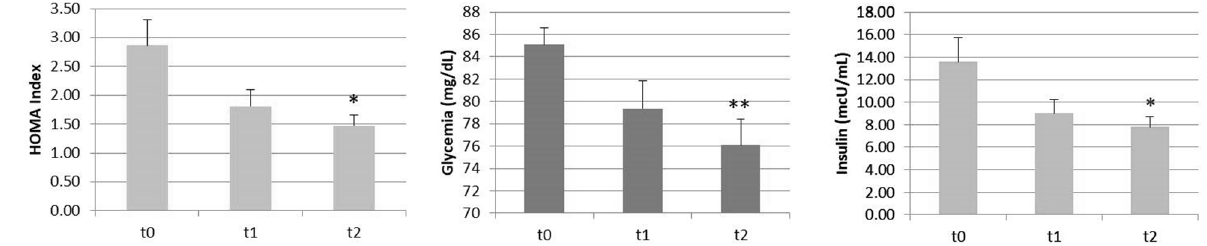
Figure 1. BBR-PP effectiveness on the primary and secondary endpoints on insulin resistance and the glycemic profile. * p ≤ 0.005; ** p < 0.0005.